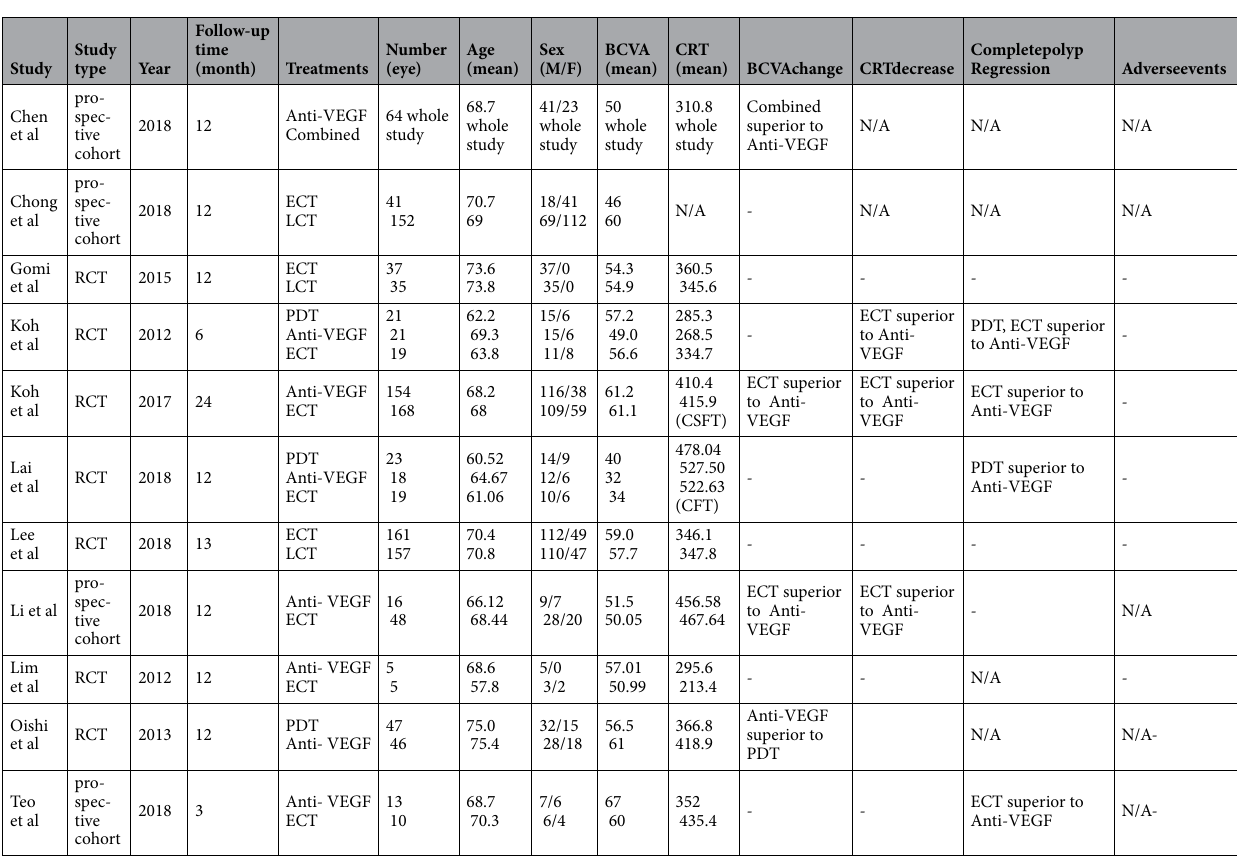
Table 1. Characteristics of studies. -, No significant difference between two comparison; Anti-VEGF, anti- vascular endothelial growth factor; BCVA, best-corrected visual acuity; CRT, central retinal thickness; ECT, early combination therapy; LCT, late combination therapy; PDT, photodynamic therapy; N/A, no information of comparison in the